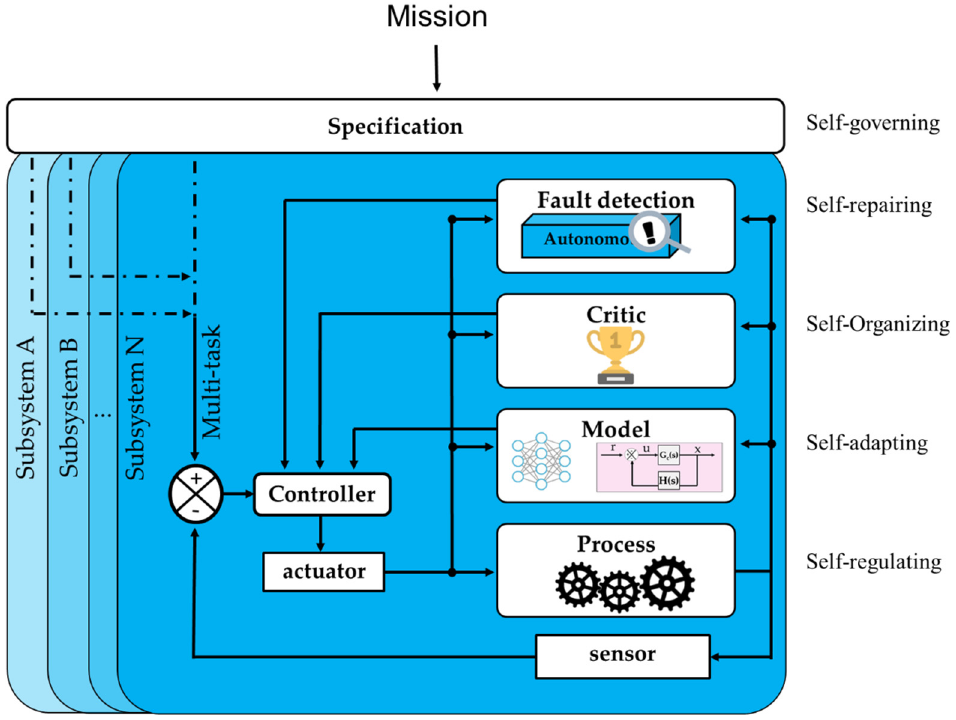
Figure 3. The autonomous system structure .